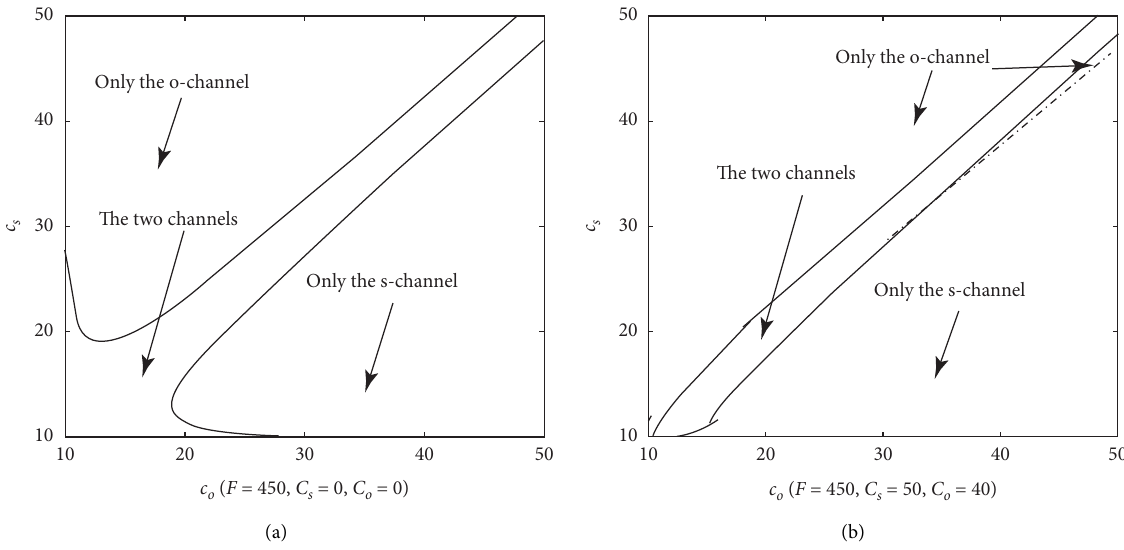
Figure 2: The channel selection strategy when borrowing is